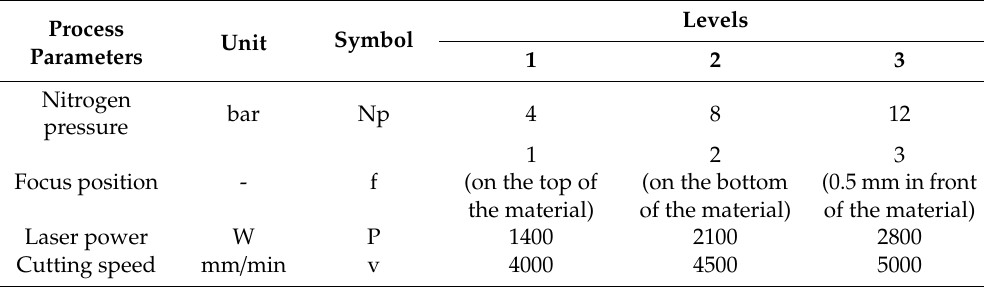
Table 4. Process parameters’